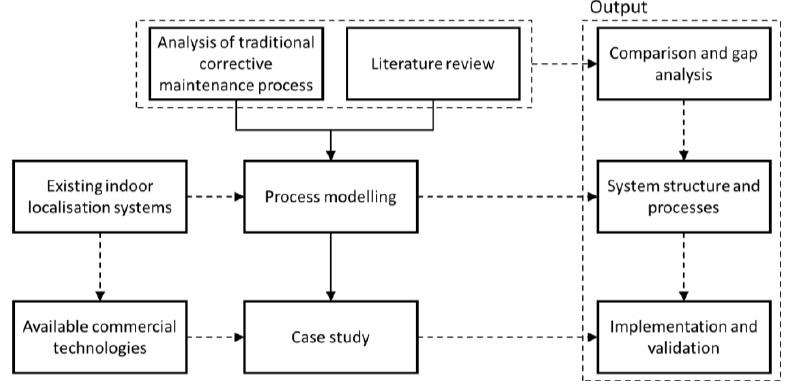
Figure 3. Schematic flowchart of research methodology.